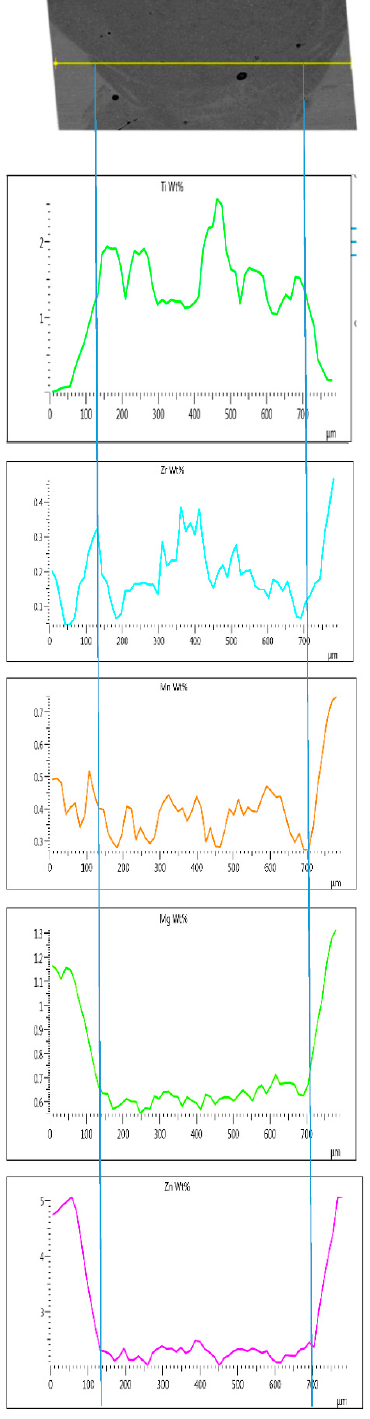
Figure 8. Elemental distribution in the base metal and weld zone of AA7020 after welding with AlTiB filler